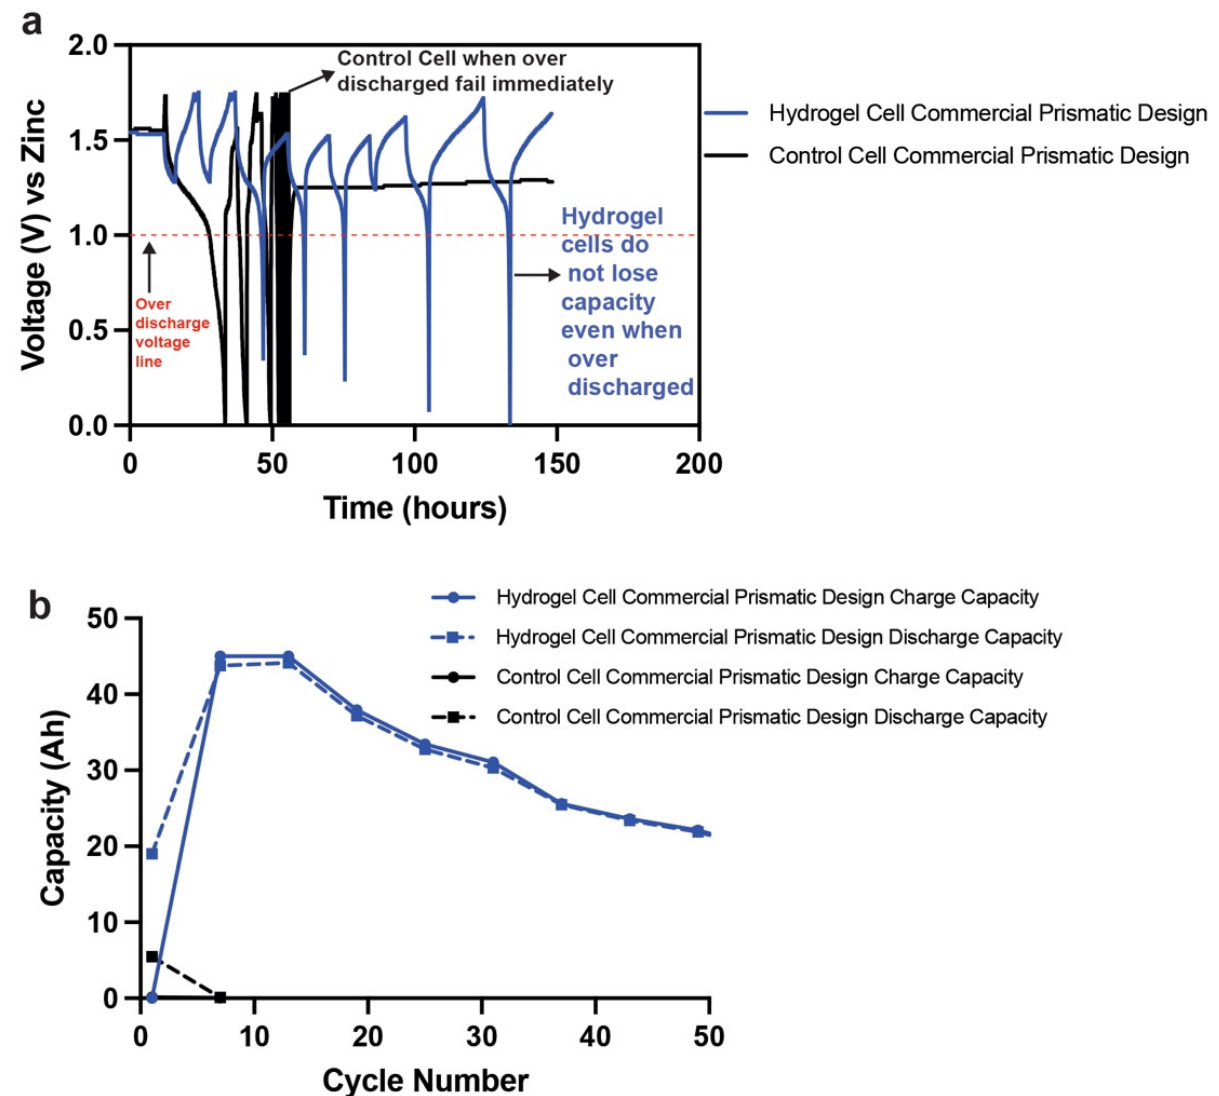
Figure 14. ( a ) Comparison of a control (liquid) and hydrogel-containing Zn–MnO 2 prismatic cell that is overdischarged. ( b ) Capacity retention of a control (liquid) and hydrogel-containing Zn–MnO 2 prismatic cell that is overdischarged.